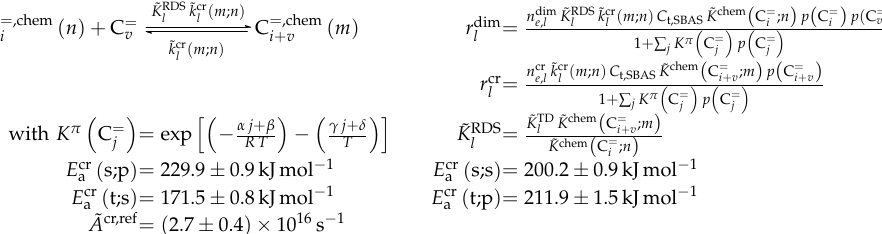
Scheme 13. Reaction network, rate equations and estimated parameters for the model by von Aretin et al. [164] with j ranging from 2 to 12 as well as i and v ranging from 2 to 10 and from 3 to 10, respectively and i + v being less than or equal to 12; when i is equal to 2, no dimerization takes place, cracking is thus irreversible in these cases; m and n resemble the types of protonated intermediates: primary, secondary or tertiary; and ˜ K chem is composed of K π , symmetry contributions, an equilibrium constant of isomerization and one of protonation (see [164]). Instead of the original parameters from [164], the slightly changed values from [244] are shown here, where ˜ K TD is calculated exclusively with thermodynamic data stemming from Benson’s group additivity method [96,97]. From the reaction rates, the net rates of production according to Scheme 14 are obtained. For better clarity, they are divided into olefins in the gas phase and the corresponding chemisorbed intermediates.